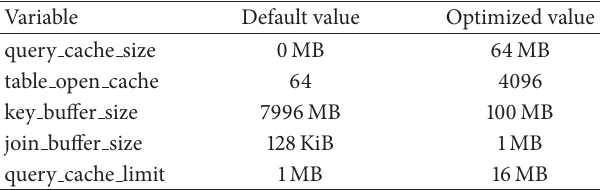
Table 6: MySQL optimization parameters.